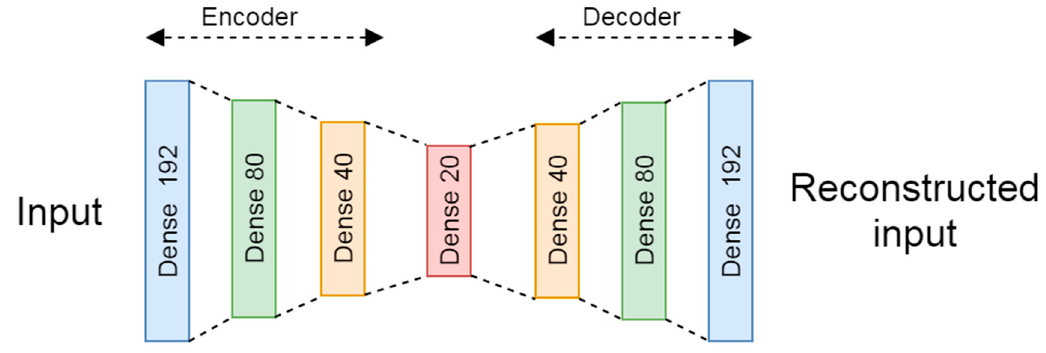
Figure 2. Denoiser auto encoder.